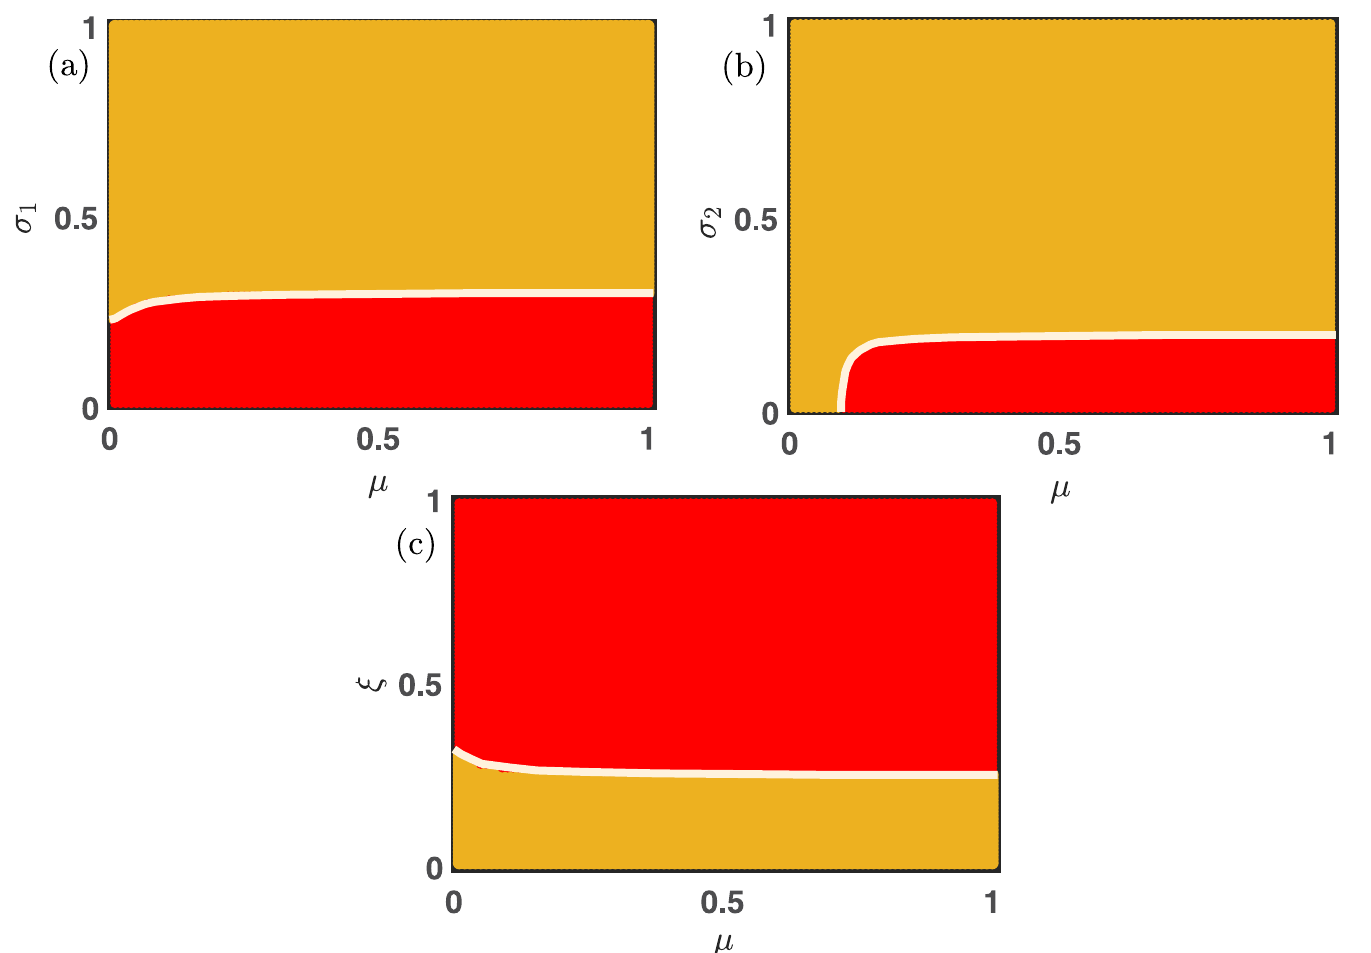
Fig 8. Effect of bidirectional mutation on the emergent dynamics. The positive mutation rate μ 2 (0, 1] allows the system (8) to settle into two stationary points depending on the choice of other parameters’ values. When the free space-induced benefits are small, all species are extinct, as depicted through subfigures (a-b). However, all strategies can coexist for suitable choices of other parameters. The red region reflects the extinction equilibrium, and the yellow region indicates the stable coexistence of cooperators and defectors. The solid white line represents the analytically derived stability curve below which the extinction equilibrium (0, 0) is locally stable in subfigures (a-b). The initial condition is chosen here as ( x 0 , y 0 ) = (0.35, 0.35). Other parameters’ values are kept fixed at ξ = 0.25, β = 1.1, η = 0.85, p = 0.30, σ 2 = 0.20, σ 1 = 0.30, unless they are varied. The moderate choice of mortality rate ξ 2 (0, 1] allows the species’ coexistence in subfigure (c). Beyond a critical value of ξ , both the cooperators as well as the defectors die, as reflected through the red region of subfigure